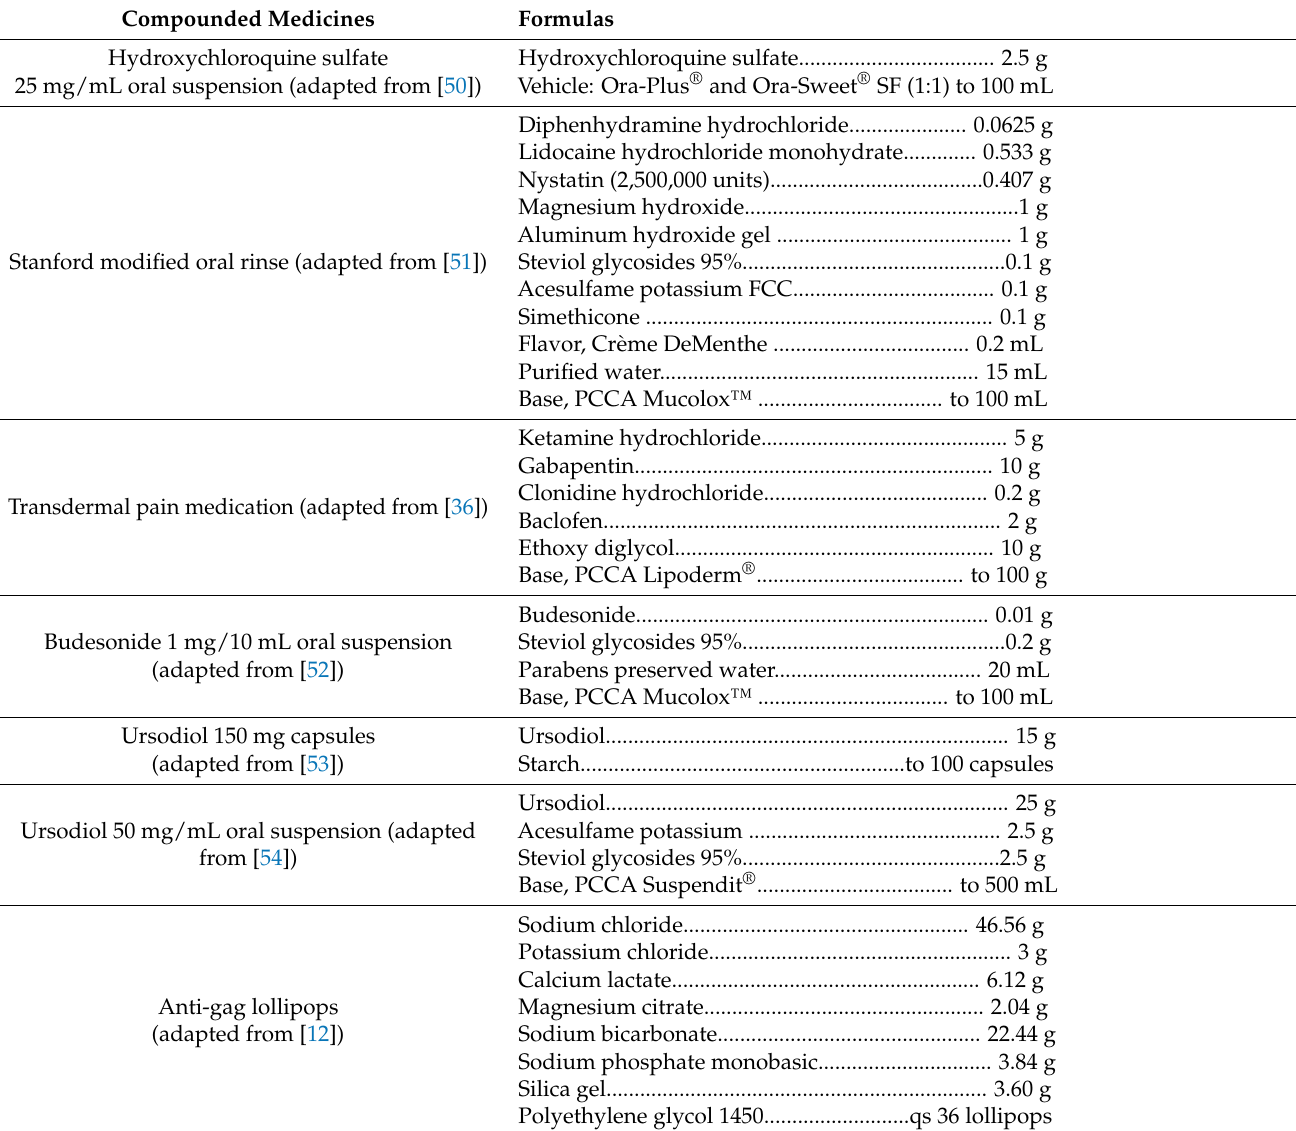
Table 1. Examples of compounded medicines and corresponding